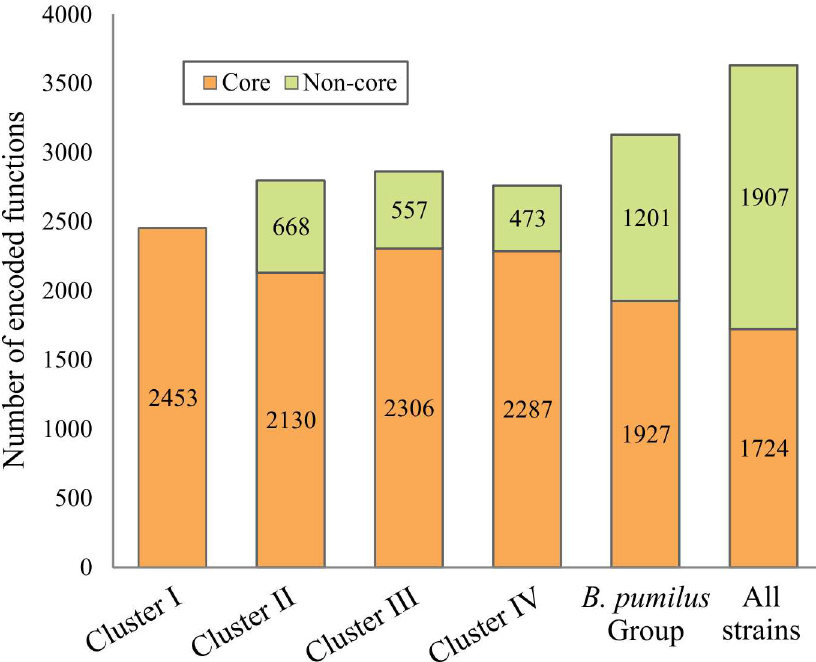
Fig 4. Analysis of functional repertoires among clusters of Bacillus pumilus group strains. Numbers of biologicalfunctions of proteins encoded in each cluster, all B . pumilus group strains or all 26 strains under analysisare